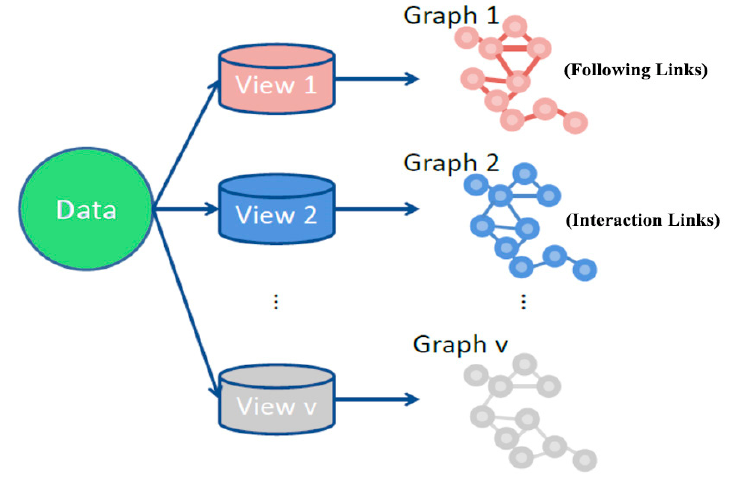
Figure 5. Multi-view perspectives in Bot-MGAT.